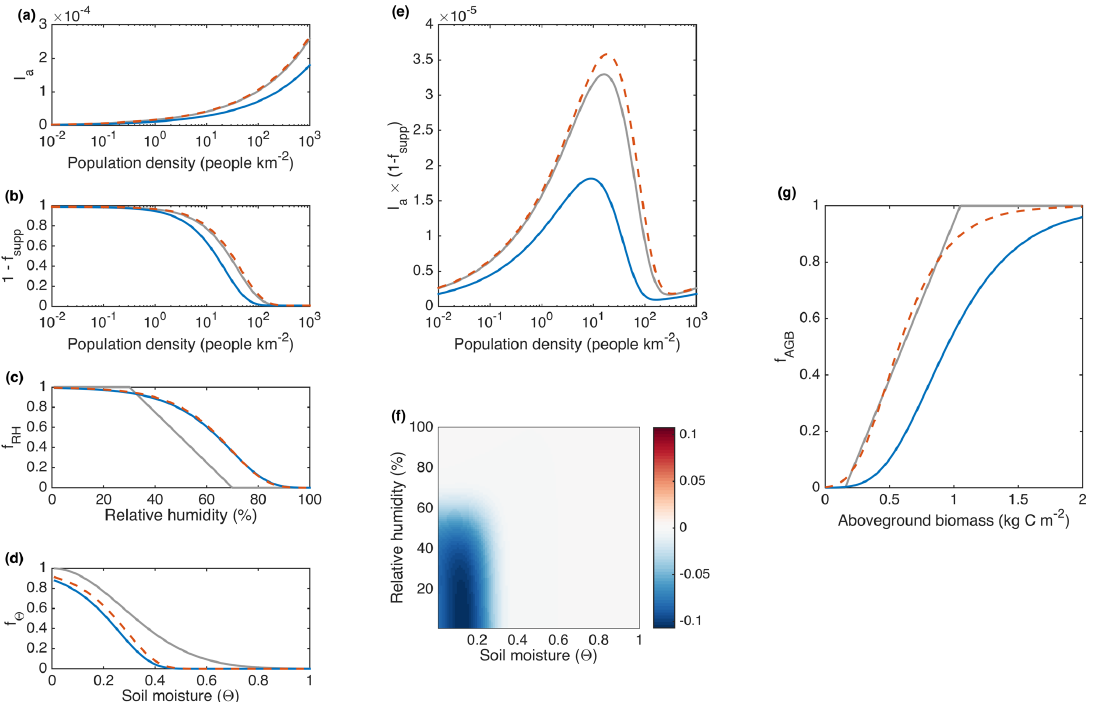
Figure 3. Optimization 3: changes in functions that were optimized, from original Li et al. (2012, 2013) functions (solid gray), to initial guesses with Gompertz-style functions where necessary (dashed red), to final parameter set (solid blue). Color bar in panel (f) indicates difference in the cubed product of f θ and f RH (range 0–1) between the original and new parameterizations, with blue indicating a lower value in the new